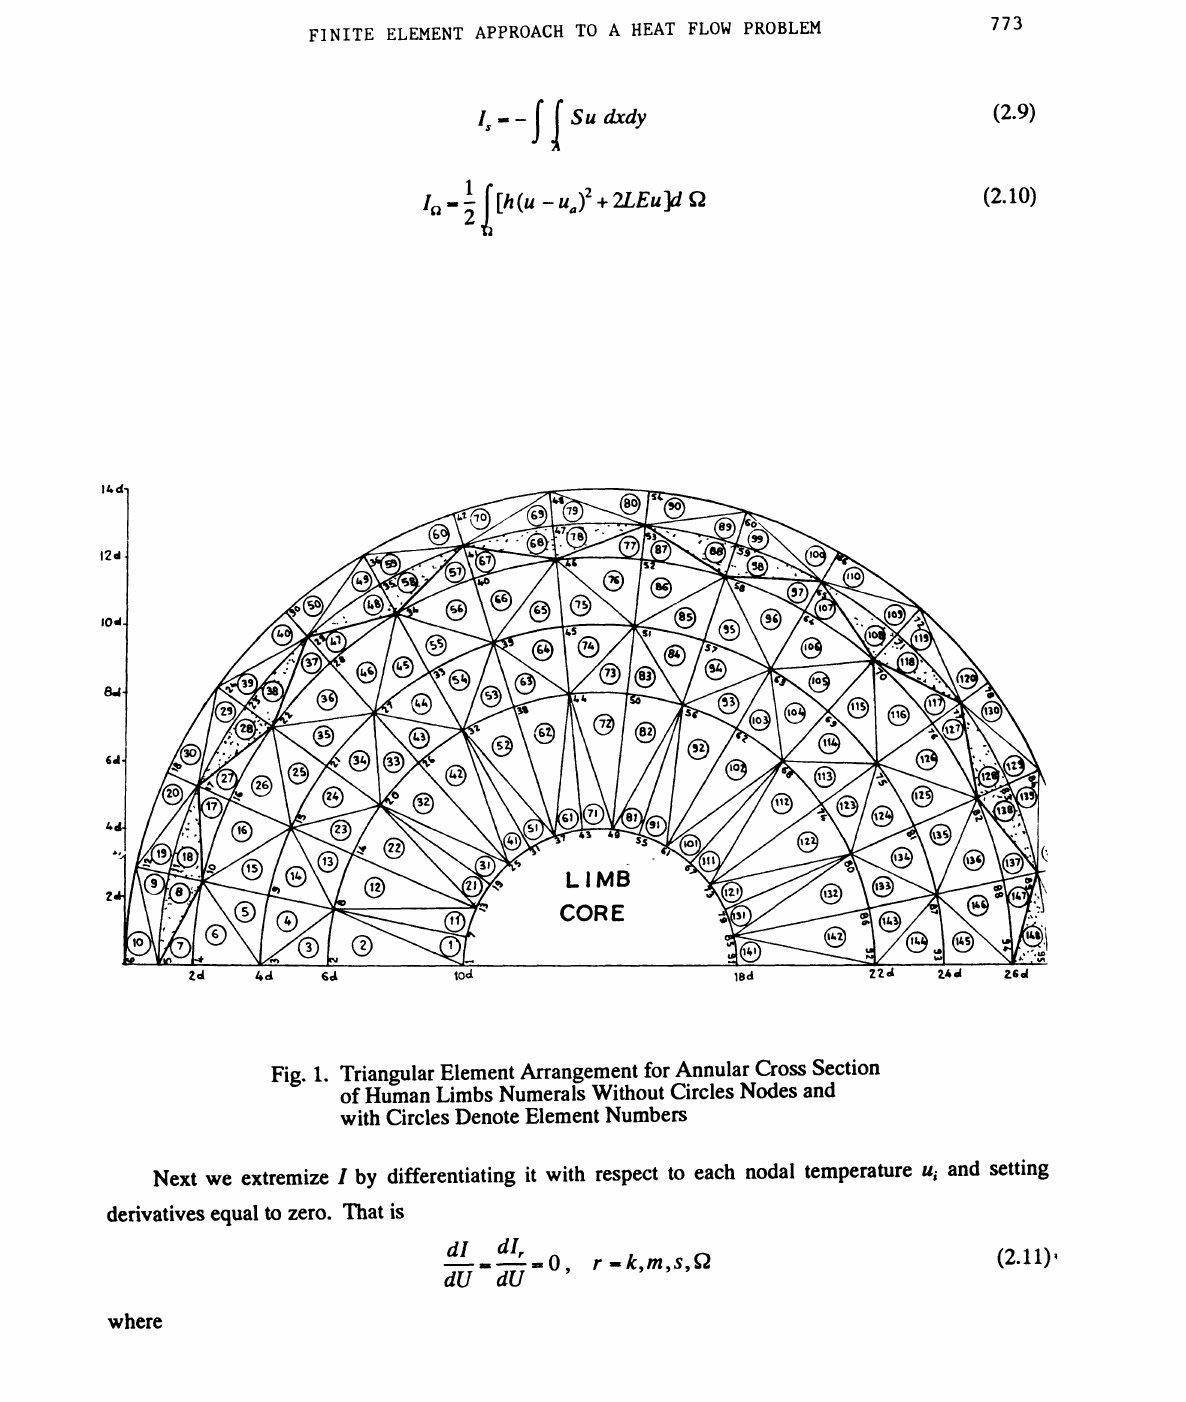
Fig. 1. Triangular Element Arrangement for Annular Cross Section of Human Limbs Numerals Without Circles Nodes and with Circles Denote Element